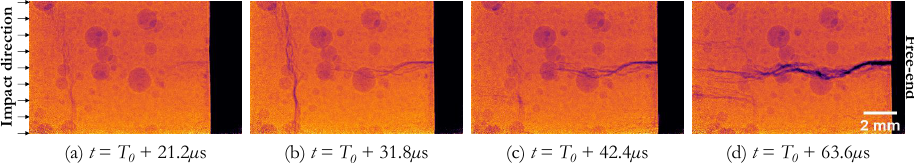
Figure 4: XPC radiographs captured during in-situ edge-on-impact test on an ultra-high strength concrete sample impacted with 190 m / s, showing the opening, closing and bridg- ing of the spall fracture at the sample rear face due to the secondary stress wave. (Impact direction is from the right hand